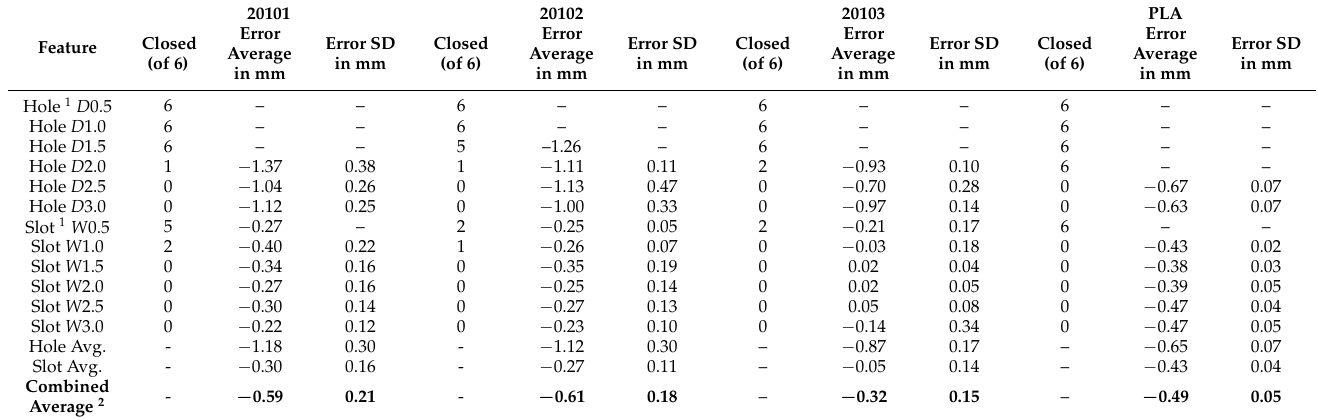
Table 4. Results from the manual profilometer measurements on the holes and slots specimens.